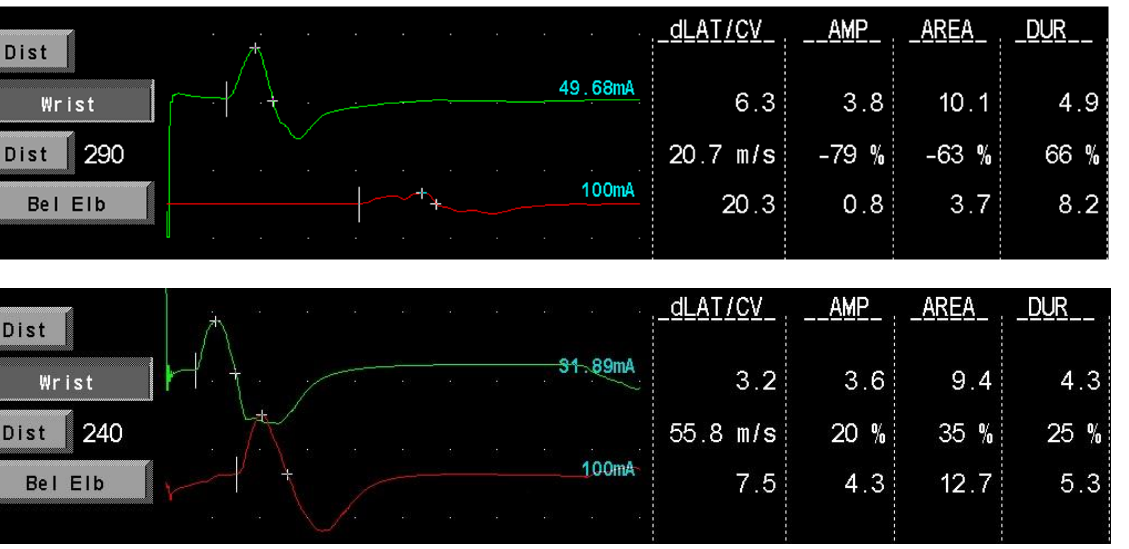
Figure 2. Patient 001 motor medial nerve conduction before ( upper image ) and during ( lower image ) SCIg therapy. The conduction block resolves with treatment. dLAT: distal latency; CV: conduction velocity; AMP: amplitude (mV); DUR: duration (msec).